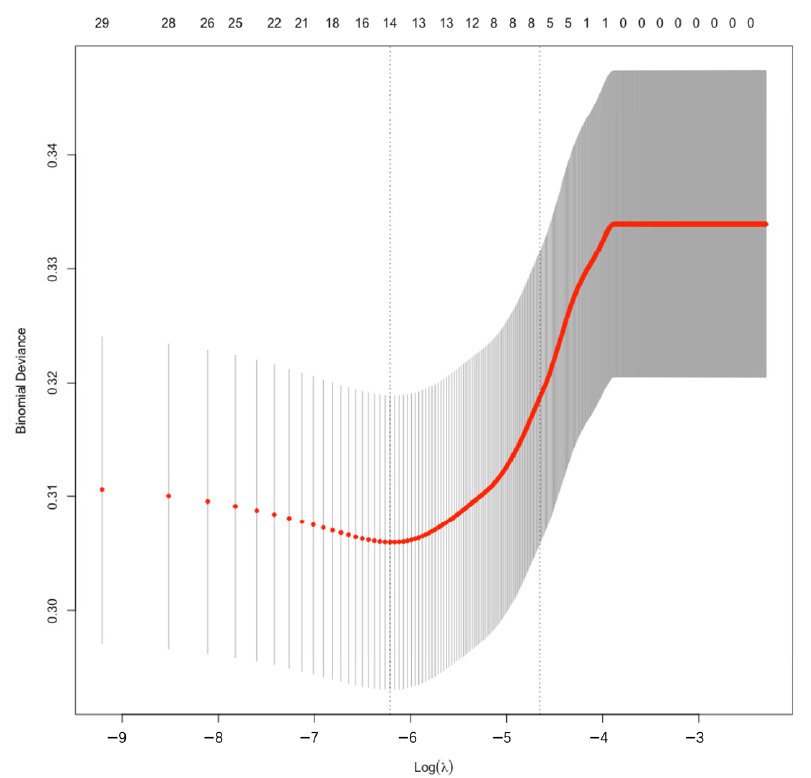
Figure 2. Log( λ ) and the error model. The 2 dashed lines in Figure 2 indicate lambda.min and lambda.1se, respectively. Lambda.min denoted the value of λ when the model error was minimal. Lambda.1se denoted the model error within a standard error range of λ .